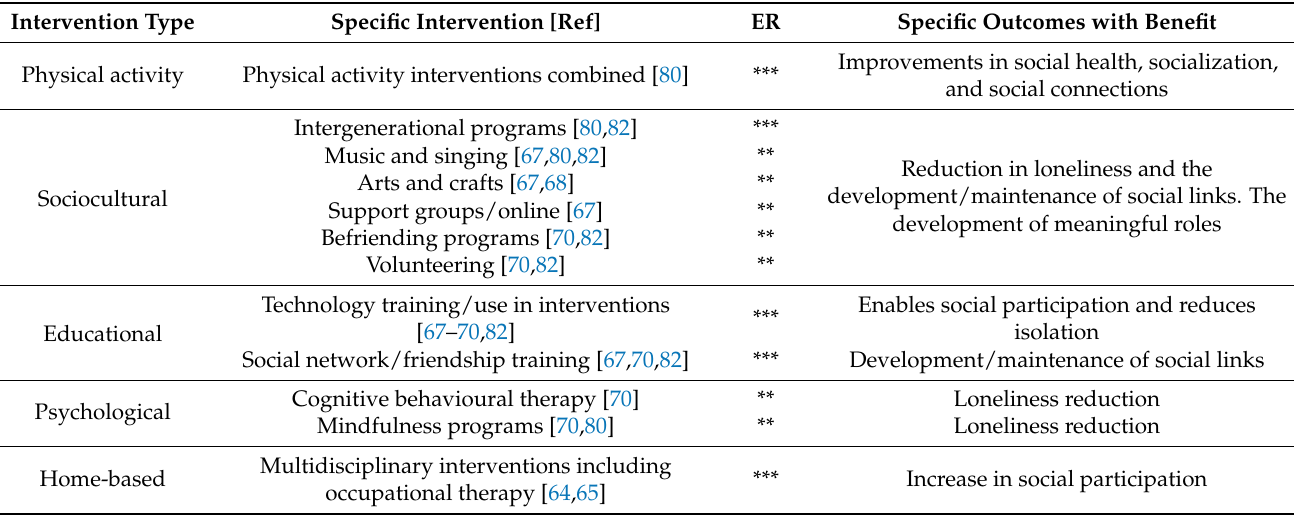
Table 7. Identified interventions for social